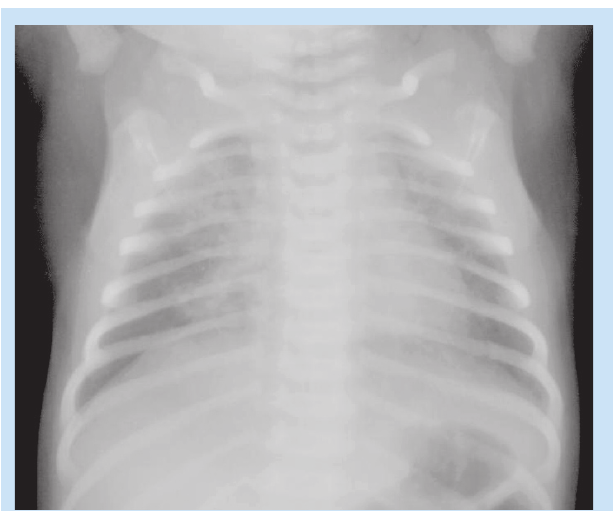
Fig. 20. Neonatal pneumonia. Right upper lobe airspace disease.